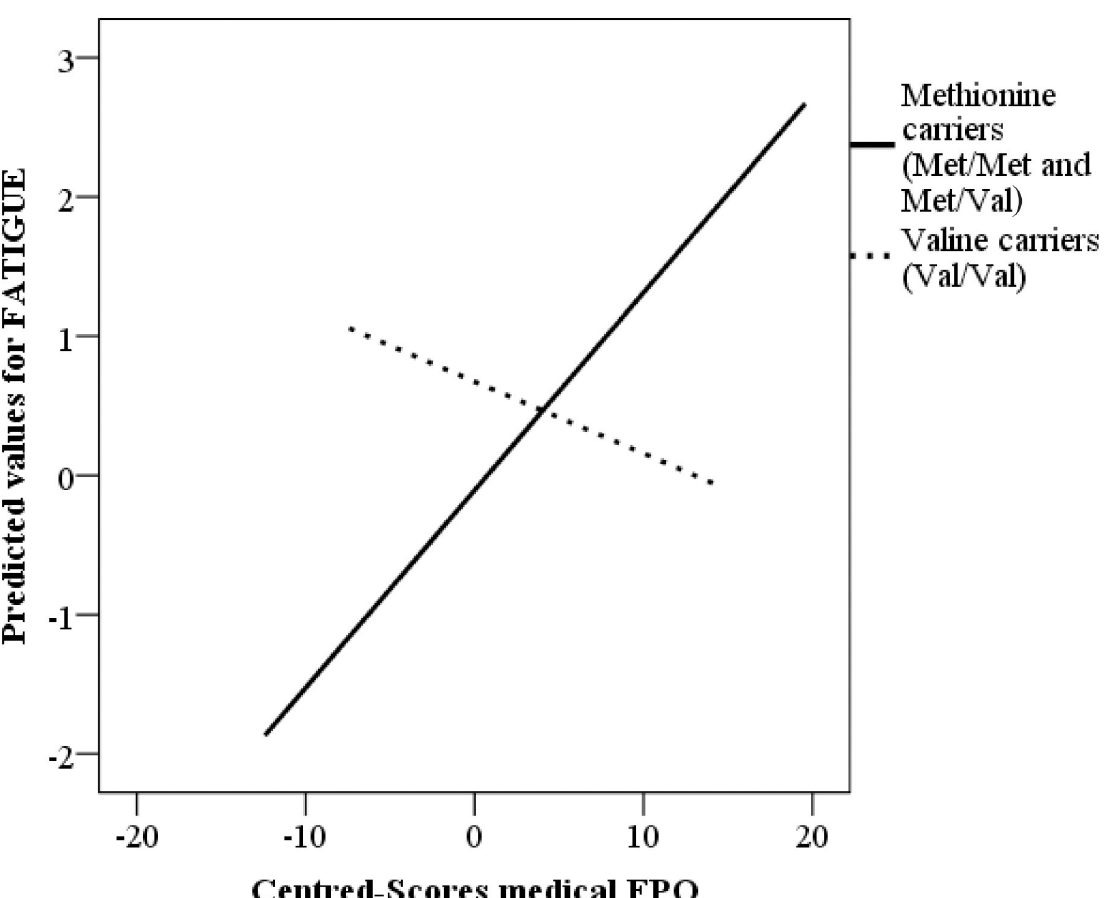
Fig 2. Medical fear of pain moderation and its relationship of COMT and